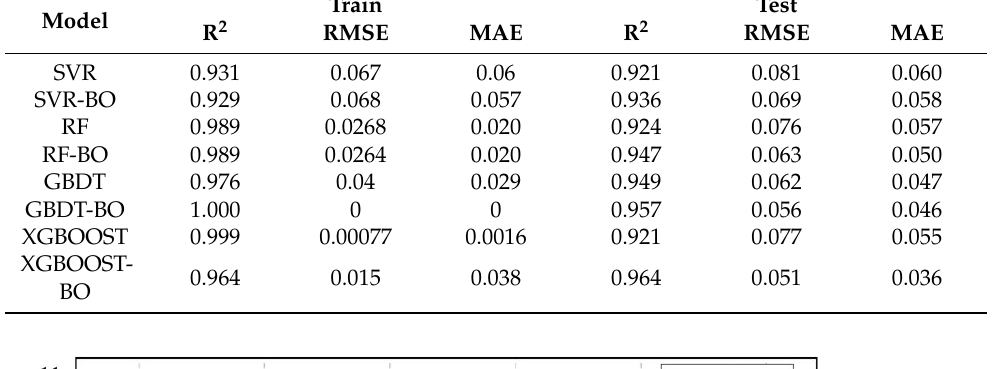
Table 4. Performance evaluation between ML models with and without BO optimization.